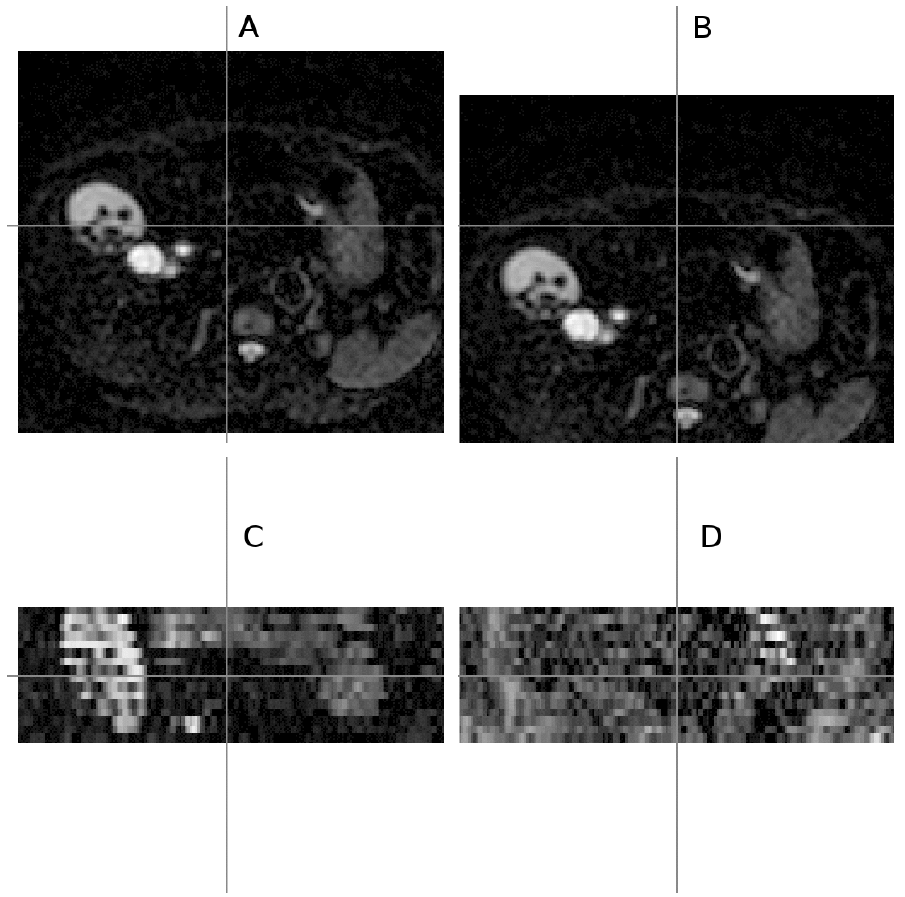
and D) show what is seen from the cross section of the horizontal line drawn on the transverse view slice (A and B); the two columns show different cross sections on the same volume; image volume selected is one of the repeat data-sets (out of 4) with diffusion gradient in − x direction; b-value = 100 s / mm 2 ; gamma adjusted.